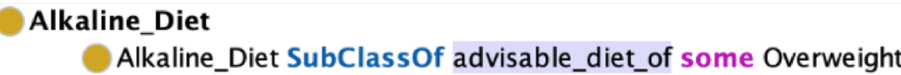
Figure 3. Axiom to link a diet with the user’s health